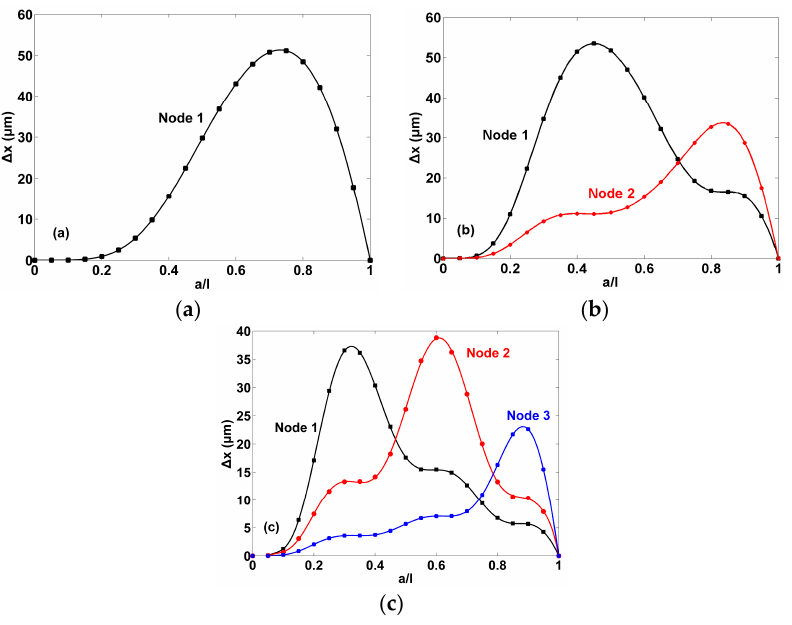
Figure 3. Behavior of nodal shift Δ x of the cantilever with different mass load distribution ( a / l ) under: ( a ) Second-order resonance; ( b ) Third-order resonance; ( c ) Fourth-order resonance where ρ m A m / ρ 0 A 0 = 1.